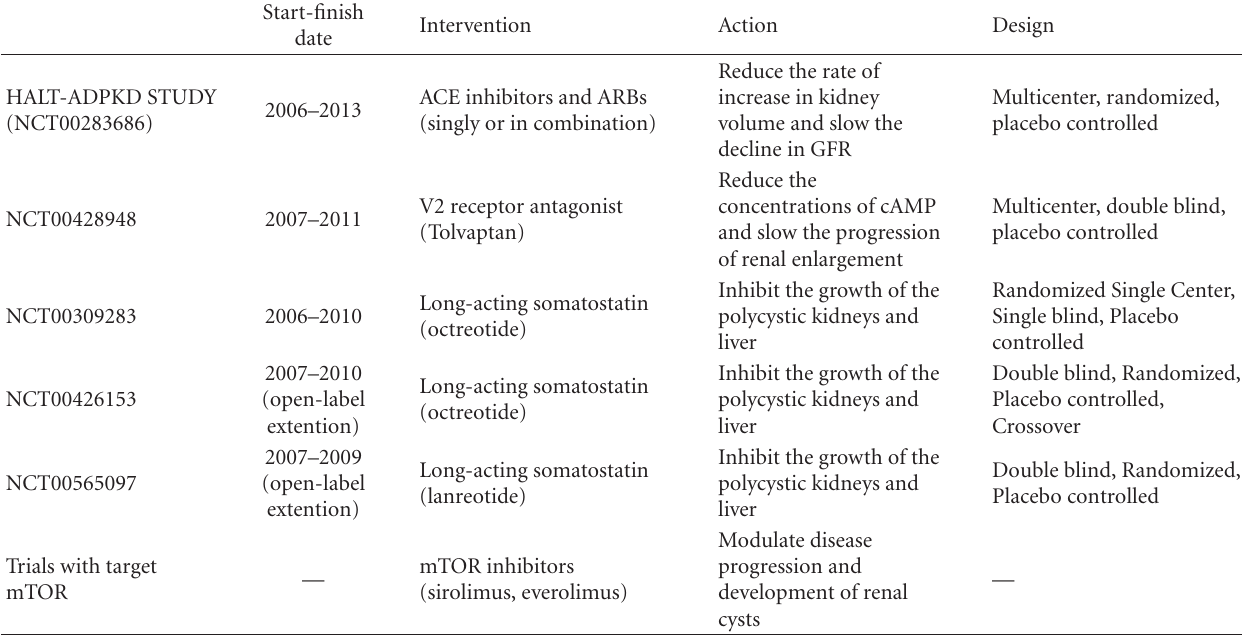
Table 3: Clinical trials for